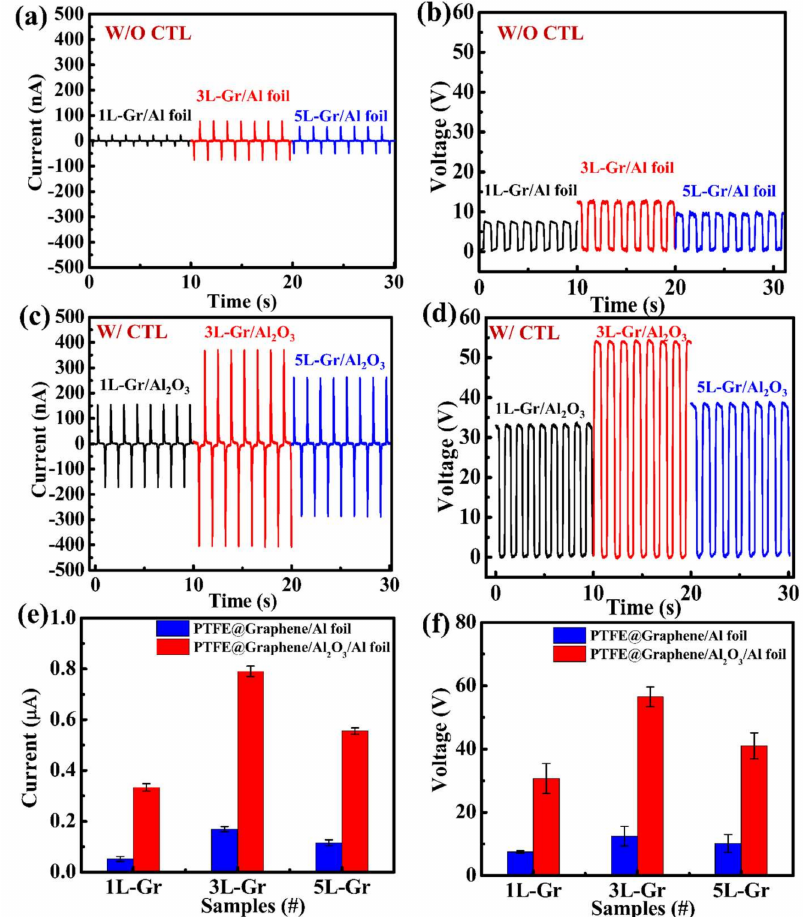
Figure 6. Electrical output of the Gr-TENG: ( a ) Short-circuit current (I SC ) and ( b ) open-circuit voltage (V OC ) of 1L-, 3L- and 5L-Gr-TENGs without Al 2 O 3 CTL. ( c ) I SC and ( d ) V OC of 1L-, 3L- and 5L-Gr-TENGs with Al 2 O 3 CTL. Average mean ( e ) current and ( f ) voltage generated by pristine Gr-TENGs (1L, 3L and 5L) and Gr-TENGs (1L, 3L and 5L) with Al 2 O 3 CTL. Error bars indicate standard deviations for 4 sets of data